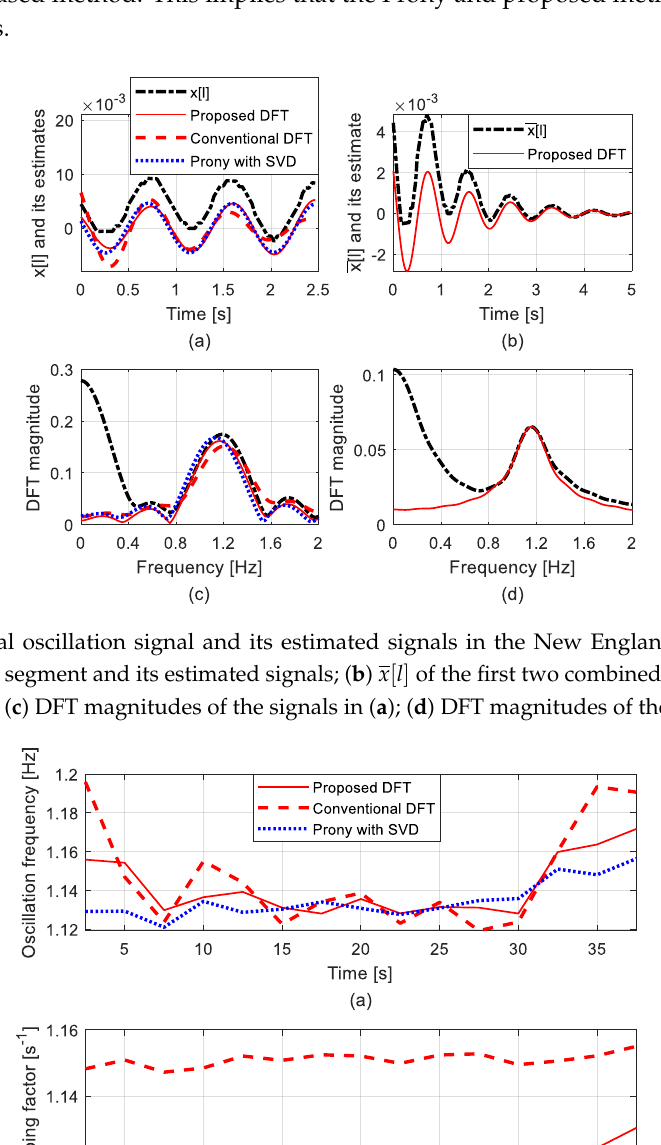
Figure 10. Modal oscillations in the system frequency of the New England power system: ( a ) PMU data; ( b ) oscillation data for modal identification; ( c ) DFT magnitude of the oscillation data.